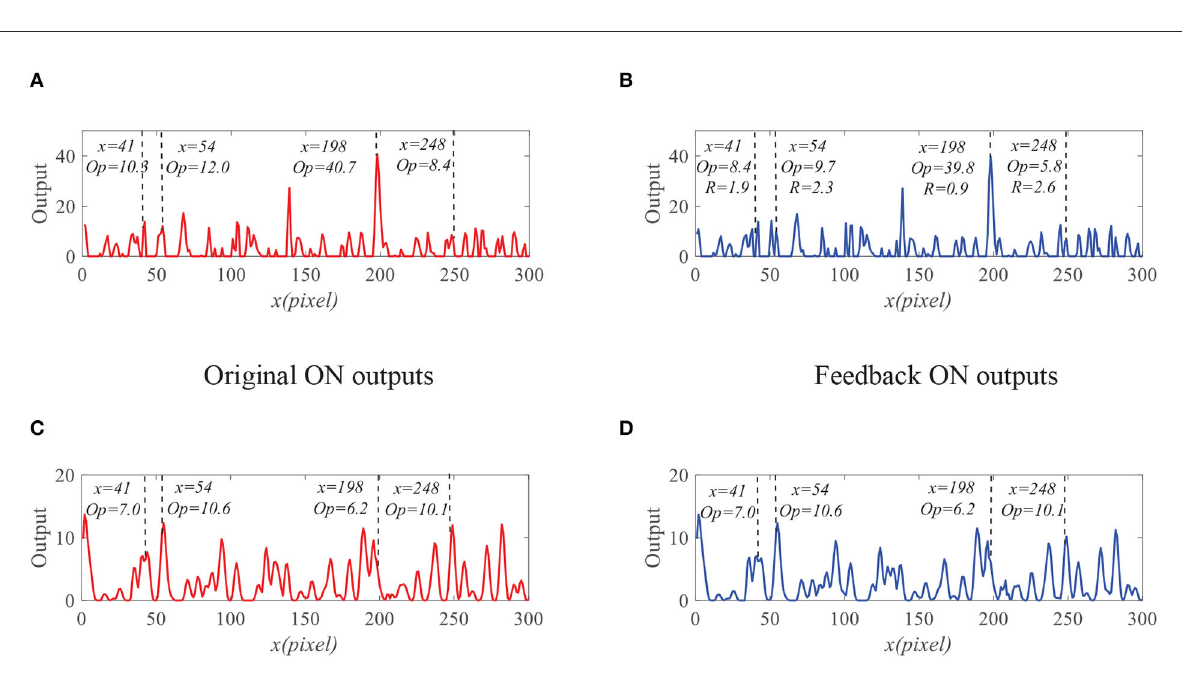
the D R F A curves of three models for the initial synthetic − image sequence. It can be seen that the feedback model has higher detection rates compared with ESTMD and DSTMD for